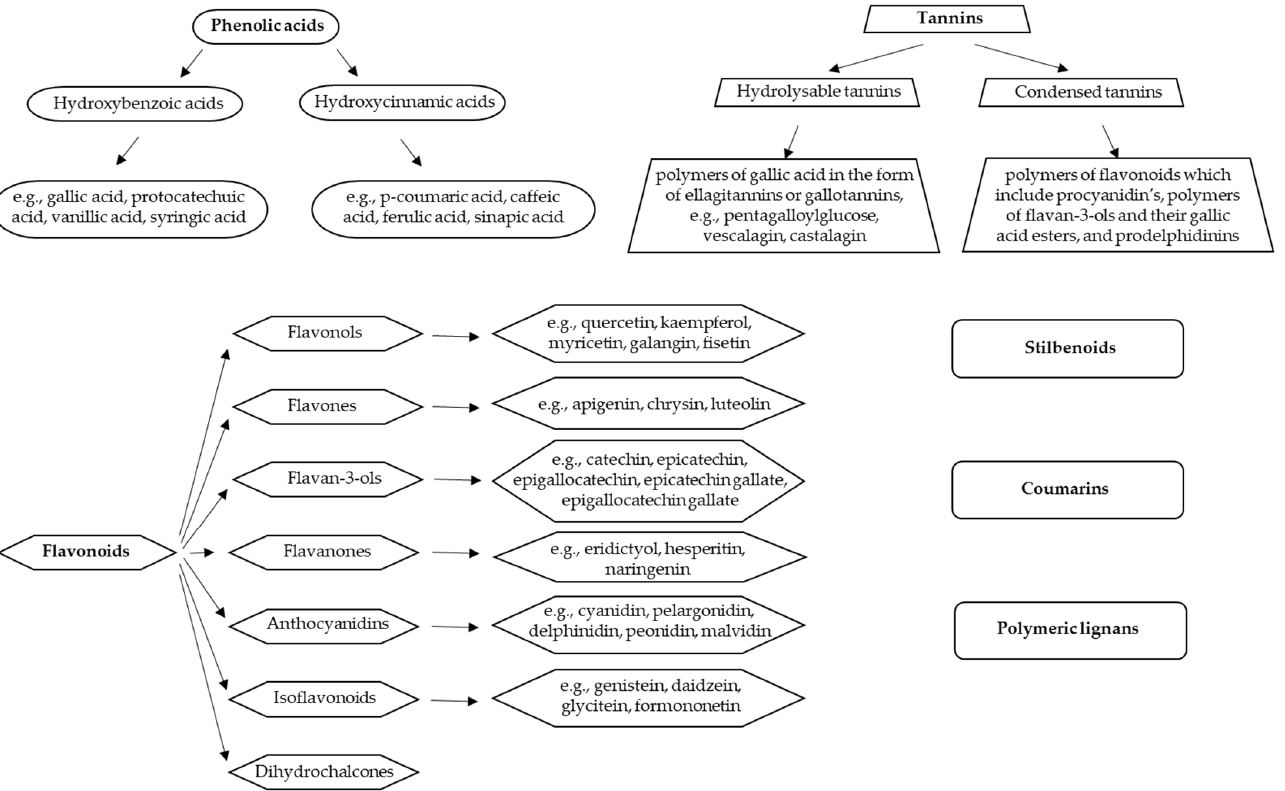
Figure 1. Classification of polyphenols and the most important representatives of individual groups (adapted from Dobson et al. [18]).